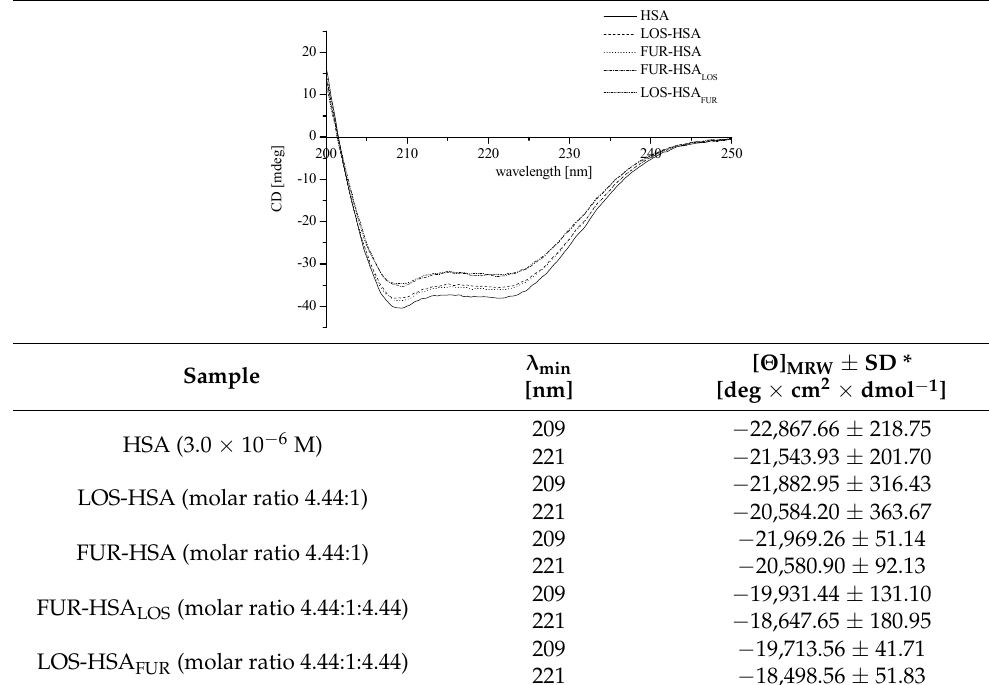
Table 3. CD spectra and the values of HSA mean residue ellipticity [ Θ ] MRW in the sample without drugs (HSA) and in the presence of drugs, in the binary LOS-HSA and FUR-HSA and ternary FUR-HSA LOS and LOS-HSA FUR systems.